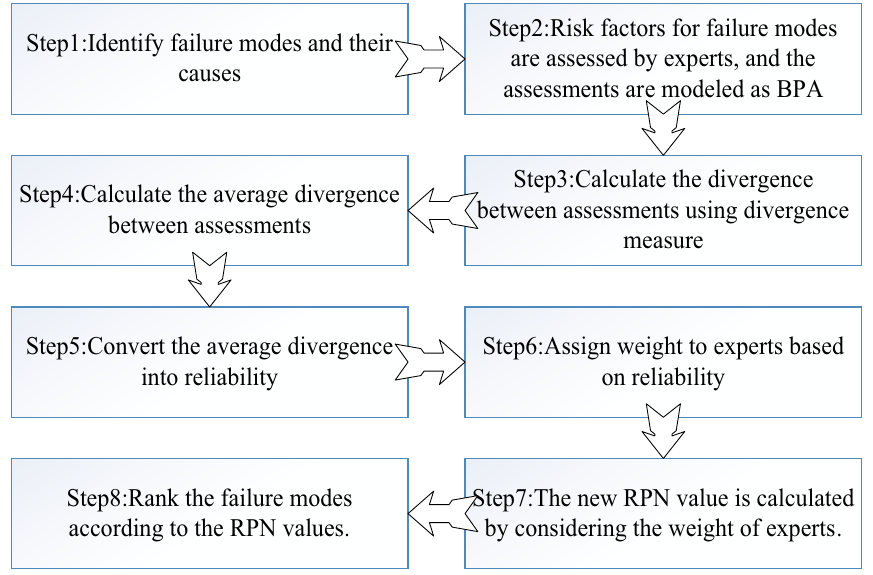
Figure 1. Flow chart of calculating RPN value with the proposed method.